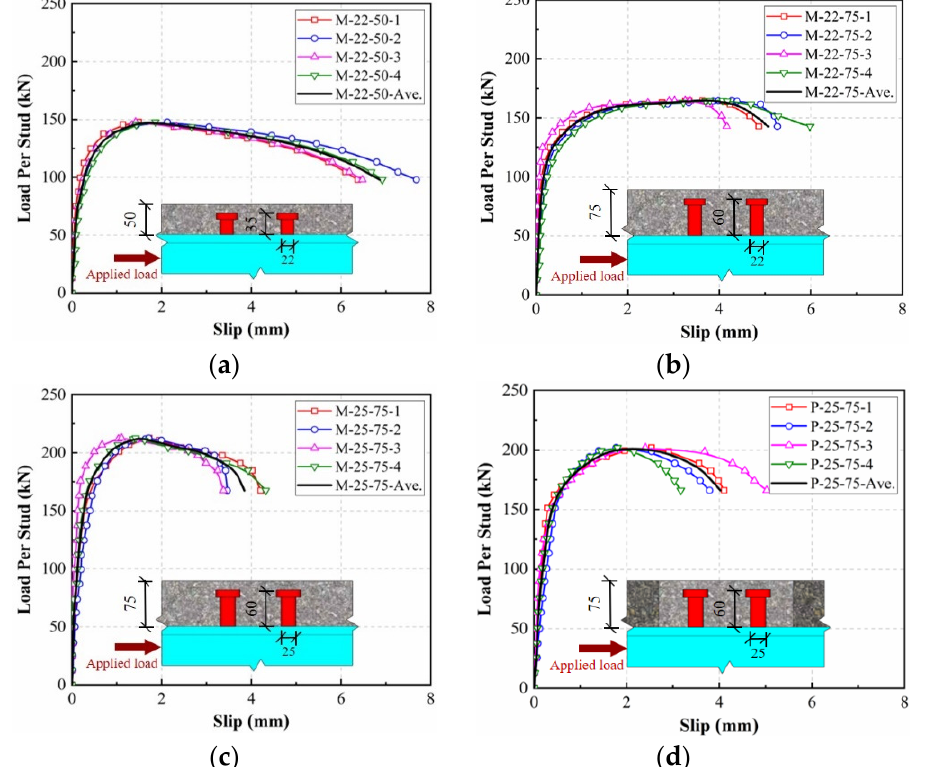
Figure 5. Load–slip curves for each specimen: ( a ) specimen M-22-50; ( b ) specimen M-22-75; ( c ) spec- imen M-25-75; ( d ) specimen P-25-75.